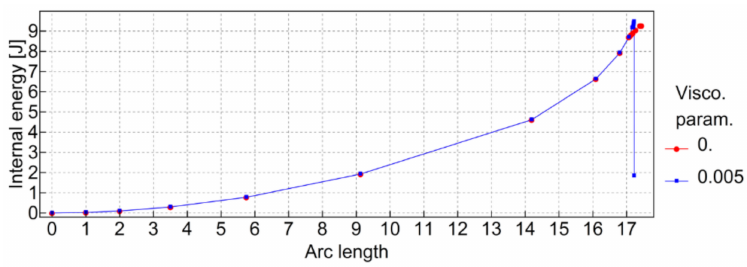
Figure 13. Internal energy comparison for the whole model with and without viscous stabilization.